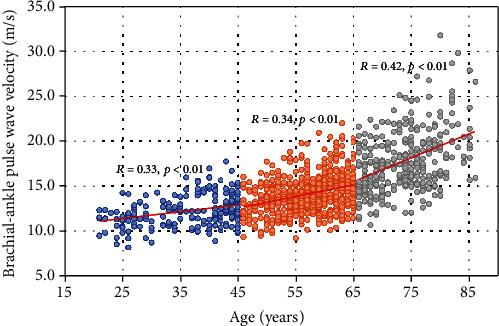
The scatter diagram between age and brachial-ankle pulse wave velocity in different age groups. Blue circles represent people aged ≤45 years, orange circles represent people aged between 46 and 65 years, and grey circles represent elderly people (>65 years).